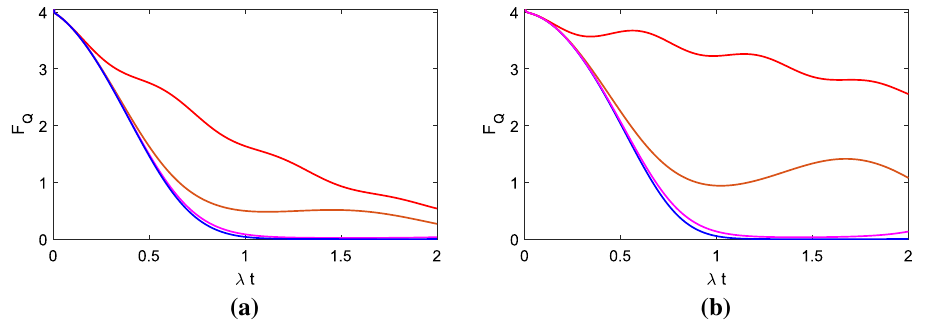
Figure 2. QFI vs. (cid:31) t . Here we provide D / (cid:31) = 0.01 , g / (cid:31) = 0 (blue), g / (cid:31) = 1 (pink), g / (cid:31) = 2.5 (brown) and g / (cid:31) = 10 (red). ( a ) γ/ (cid:31) = 1 (cid:31) = 1 4 ; ( b ) γ/ 20 .